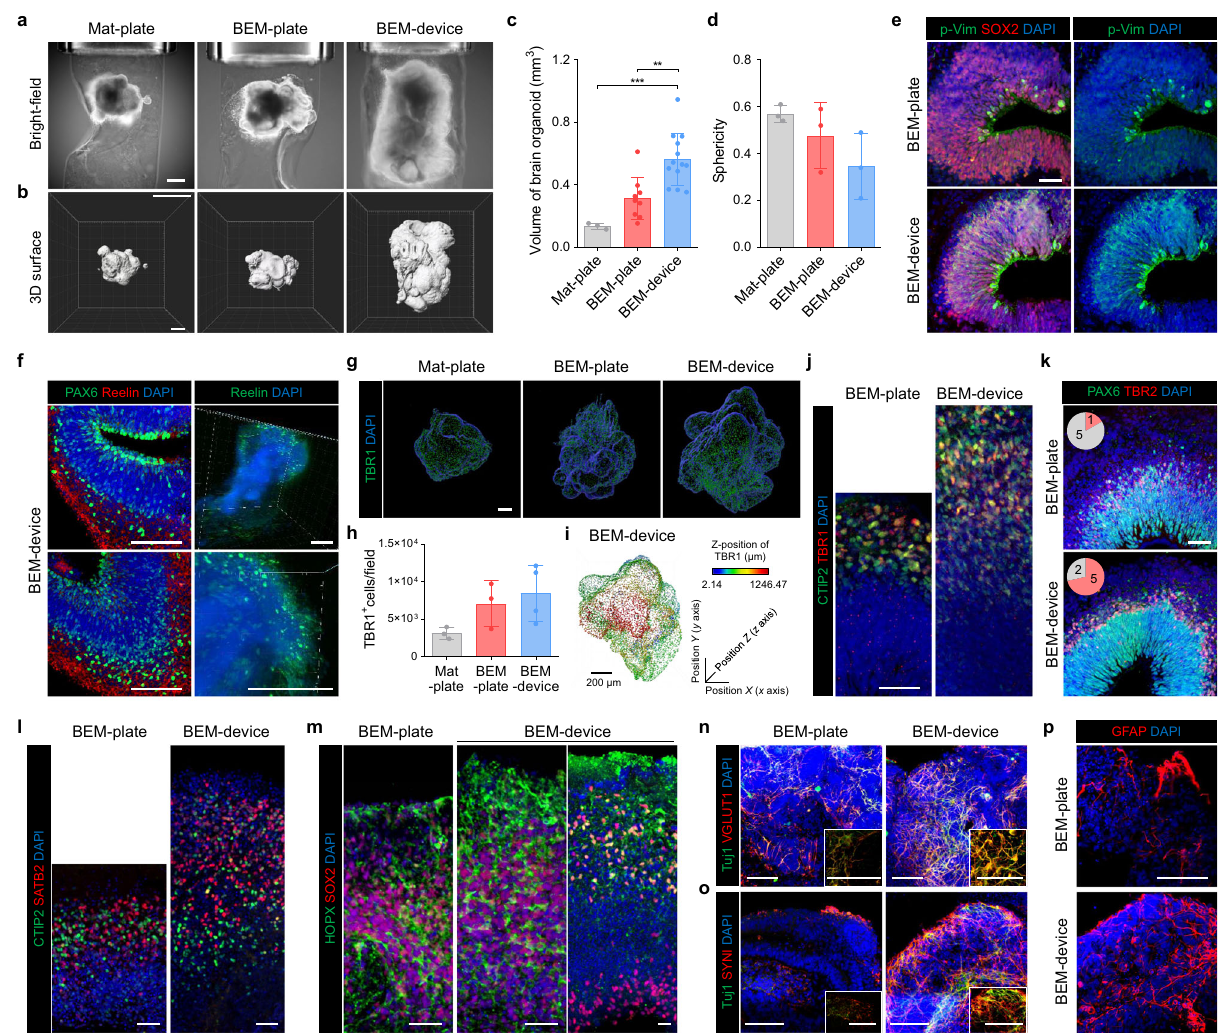
Fig. 6 Bioengineering of the brain organoids by the micro fl uidic BEM system improves radial glial generation and cortical organization. a Light-sheet microscopic bright- fi eld images of 3D brain organoids encapsulated in Mat and BEM cultured in a plate or micro fl uidic device at 60 days of culture (scale bar = 500 μ m, independent replicates = 3). b Reconstructed light-sheet microscopic images of 60-day Mat-plate, BEM-plate, and BEM-device organoids (scale bar = 500 μ m, independent replicates = 3). c Quanti fi cation analyses for the 3D organoid volume ( n = 3, 9, and 13 for Mat-plate, BEM-plate, and BEM-device groups, respectively, Mat-plate versus BEM-device p = 0.0007, BEM-plate versus BEM-device p = 0.0014, independent replicates = 3), and ( d ) sphericity ( n = 3 per group, independent replicates = 3) of brain organoids using IMARIS software. e Representative immunostaining images for mitotic radial glia marker phosphorylated vimentin (p-Vim) and SOX2 in the BEM-plate and BEM-device organoids at day 30 (scale bar = 50 μ m, independent replicates = 5). f Expression of the radial glial marker PAX6 and extracellular glycoprotein marker Reelin in BEM-device organoids (left panel, scale bars = 200 μ m, independent replicates = 2) and 3D imaging of Reelin expression in BEM-device organoids at day 30 (right panel, scale bars = 200 μ m, technical replicates = 5). g 3D plotting and ( h ) quanti fi cation of deep-layer marker TBR1-expressing cells in Mat-plate, BEM-plate, and BEM- device organoids at day 30 using IMARIS software ( n = 3 for Mat-plate and BEM-plate groups, and n = 4 for BEM-device group, independent replicates = 3). i 3D plotting analysis of TBR1 + cells in BEM-device organoids on different z-positions in the radiometric color spectrum (scale bar = 200 μ m, biological replicates = 3). j Immunohistochemically stained sections for TBR1 and CTIP2 at day 45 (scale bar = 50 μ m, independent replicate = 1). k Immunohistochemical staining images for subventricular marker TBR2 and PAX6 at day 45 (scale bar = 50 μ m, independent replicates = 2). Pink color in the pie-charts indicates the number of cortical structures with separated layers of TBR2 + and PAX6 + cells, and grey color indicates no layer preferences. l Immunostaining images showing CTIP2 and super fi cial-layer neuron marker SATB2 (scale bars = 50 μ m, independent replicate = 1), and ( m ) basal radial glia marker SOX2 and HOPX at day 75 (scale bars = 50 μ m, independent replicate = 1). n Immunostaining of Tuj1 and glutamatergic neuron marker VGLUT1 (independent replicates = 2), ( o ) presynaptic marker SYNI (independent replicates = 2), and ( p ) astrocyte marker GFAP in the BEM-plate and BEM-device organoids at day 60 (scale bars = 100 μ m, independent replicates = 3). All data are presented as mean ± SD. Statistical differences between the groups were determined with unpaired two-tailed t -test (** p < 0.01, *** p < 0.001). Source data are provided as a Source Data fi le. that in the BEM-plate organoids (Supplementary Fig. 17a). and BEM-device organoid samples at day 75 (Fig. 7a – c and Pearson ’ s correlation coef fi cient values between samples in the Supplementary Fig. 17). A heatmap of the differential expression same group and principal component analysis (PCA) demon- analysis showed that 214 genes were upregulated and 802 genes strated that there was less variability between the samples in the were downregulated in BEM-device organoids compared with